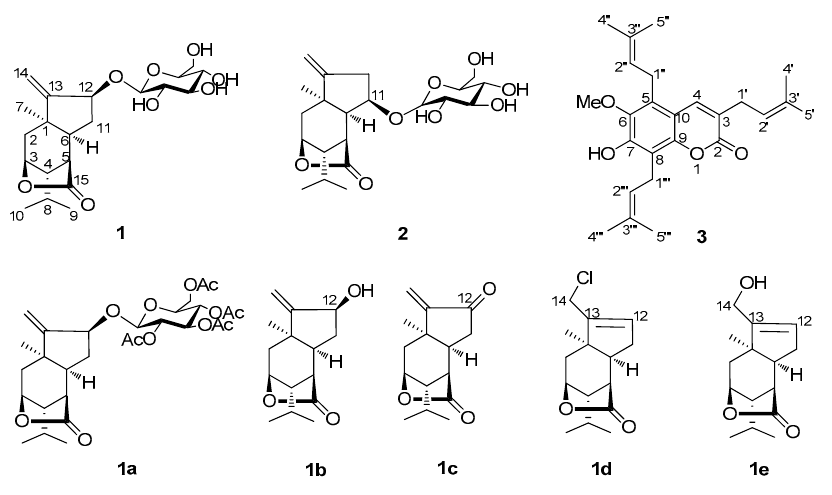
Figure 1. Chemical structures of compounds 1 – 3 and 1a – e .